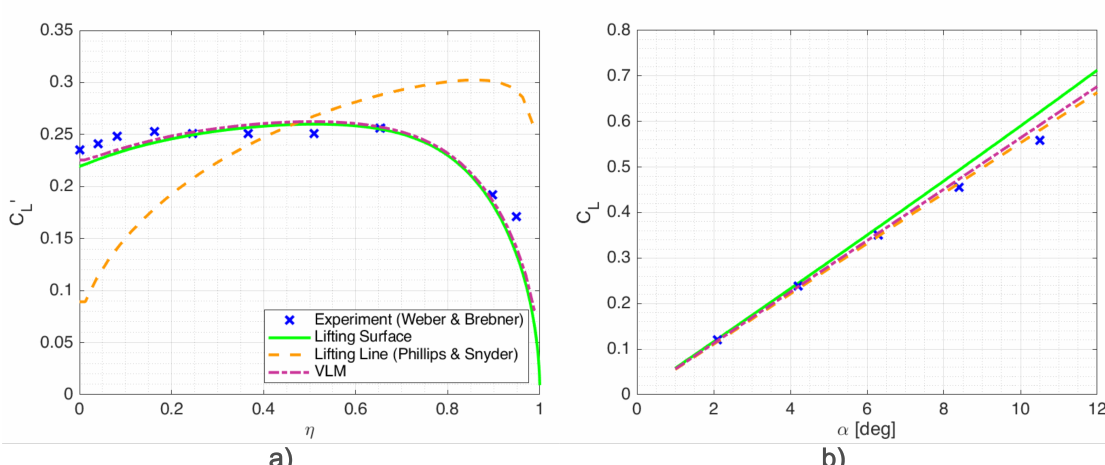
Figure A3. ( a ) Spanwise lift distribution at 4.2 degrees and ( b ) lift curve slope for the low order methods considered. All methods predict the lift curve slope well enough, however the modified lifting line model skews the lift to the outboard sections of the wing. For our analysis purposes, this would lead to large errors in the predicted induced drag and aerodynamic moments.